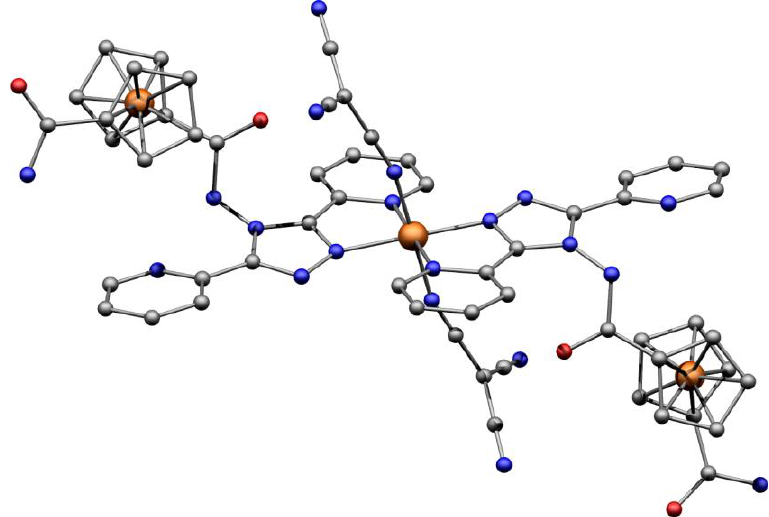
Figure 9. The DFT optimized molecular structure of 1′ in the low-spin state used for the calculation